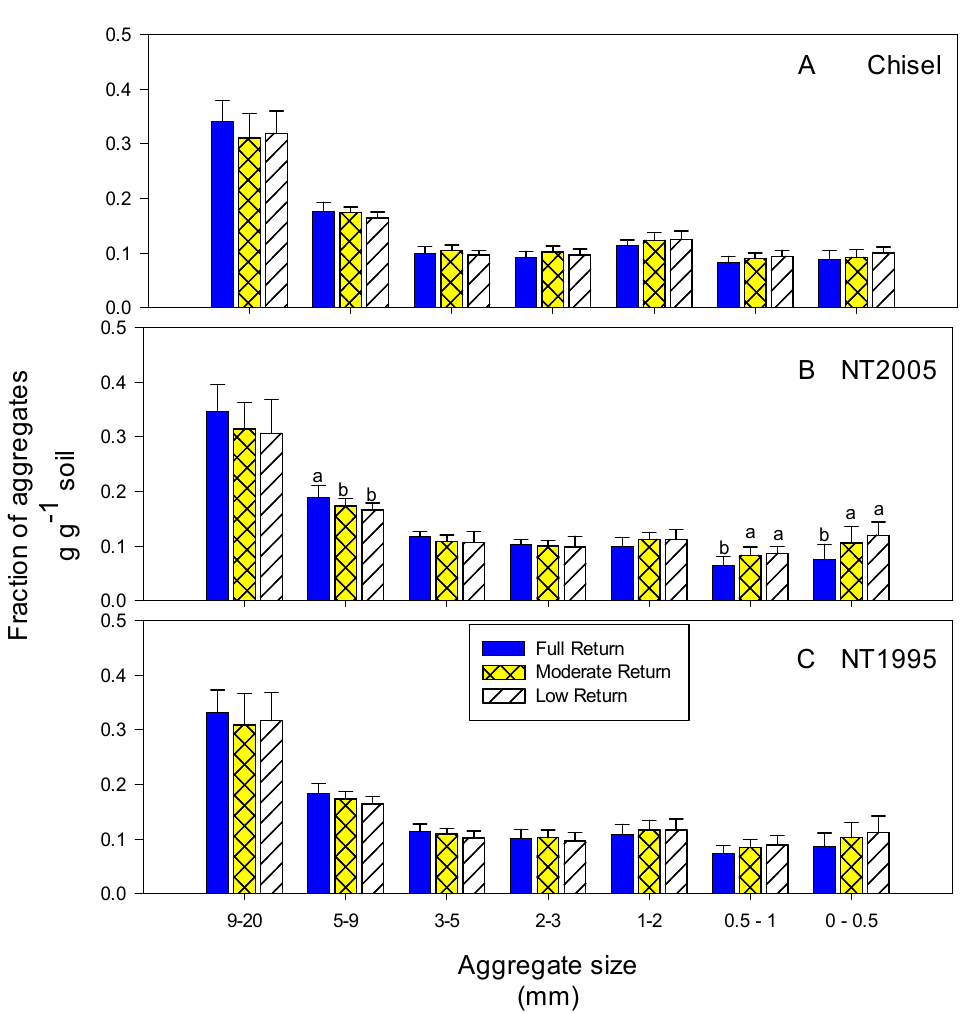
Figure 1. Dry aggregate size distribution as affected by stover return rates in ( A ) a chisel plowed field ( B ) a field managed without tillage since 2005 and ( C ) a field managed without tillage since 1995. Bars represent mean with standard error ( n = 12), which are labeled with different letters when they differ at P ≤